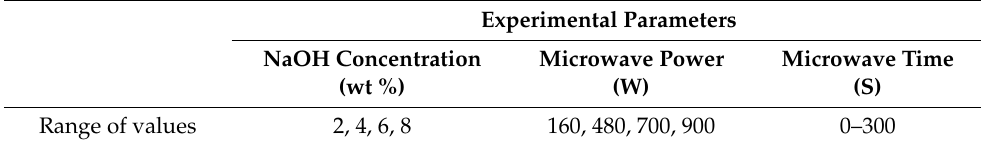
Table 1. Experimental parameters for extracting cotton stalk